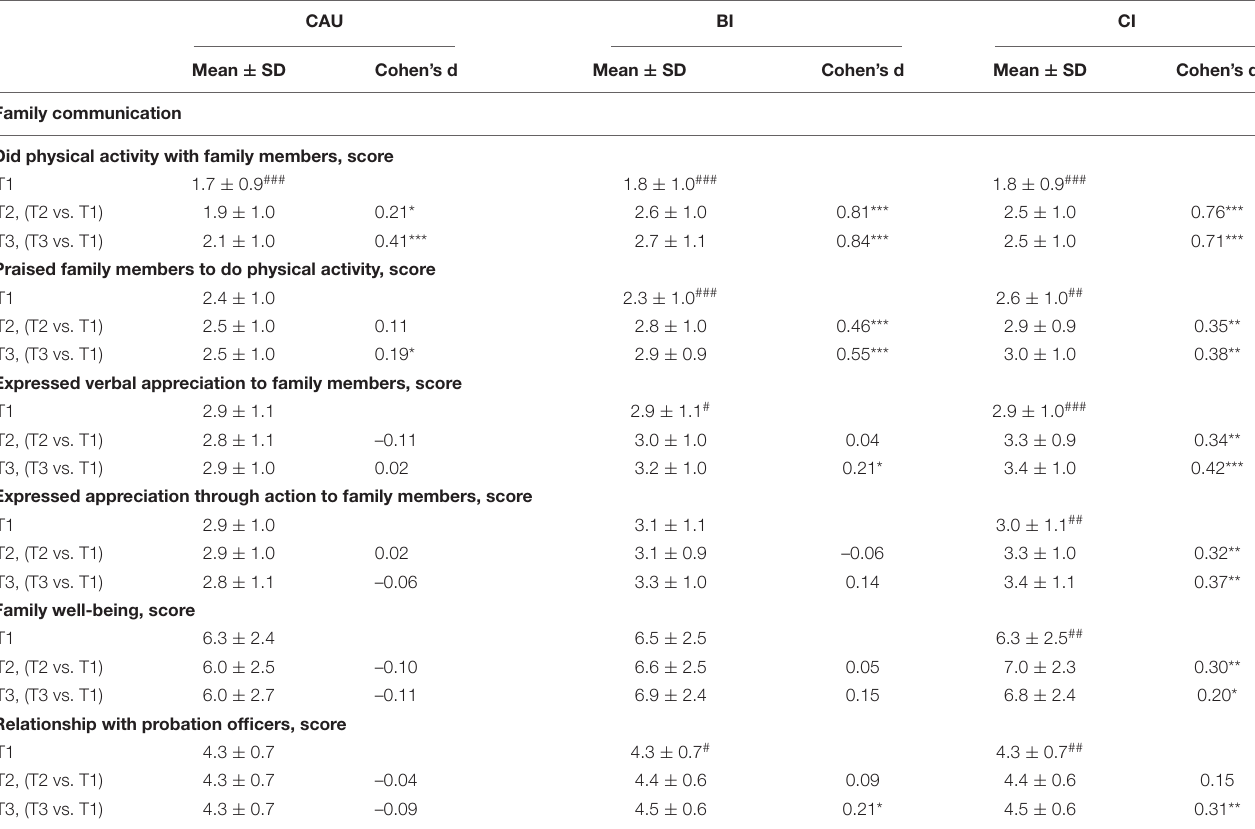
TABLE 5 | The within-group difference in family communication, family well-being, and relationship with probation officers at 1- and 3-month follow-up in three groups: Intention-to-treat analysis. CAU BI CI Mean ± SD Cohen’s d Mean ± SD Cohen’s d Mean ± SD Cohen’s